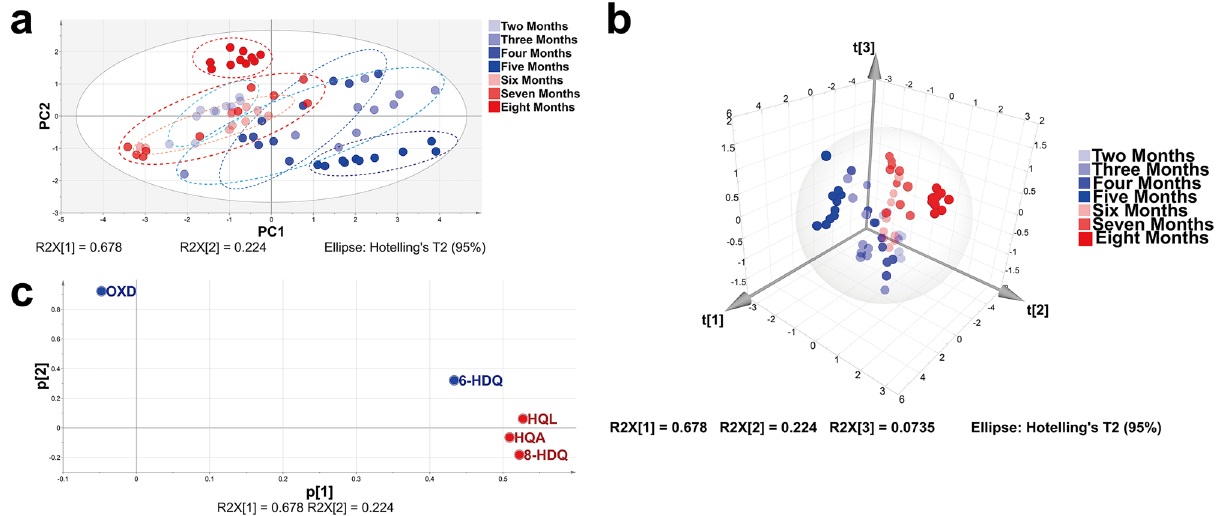
Figure 4. The results of principal components analysis (PCA) for NCMs from P. americana at the different growth stages. ( a ) Score plot of PCA model for differentiating samples at the different growth stages. ( b ) 3D score plot of PCA model based on the three principal components. ( c ) Loading score plot from PCA